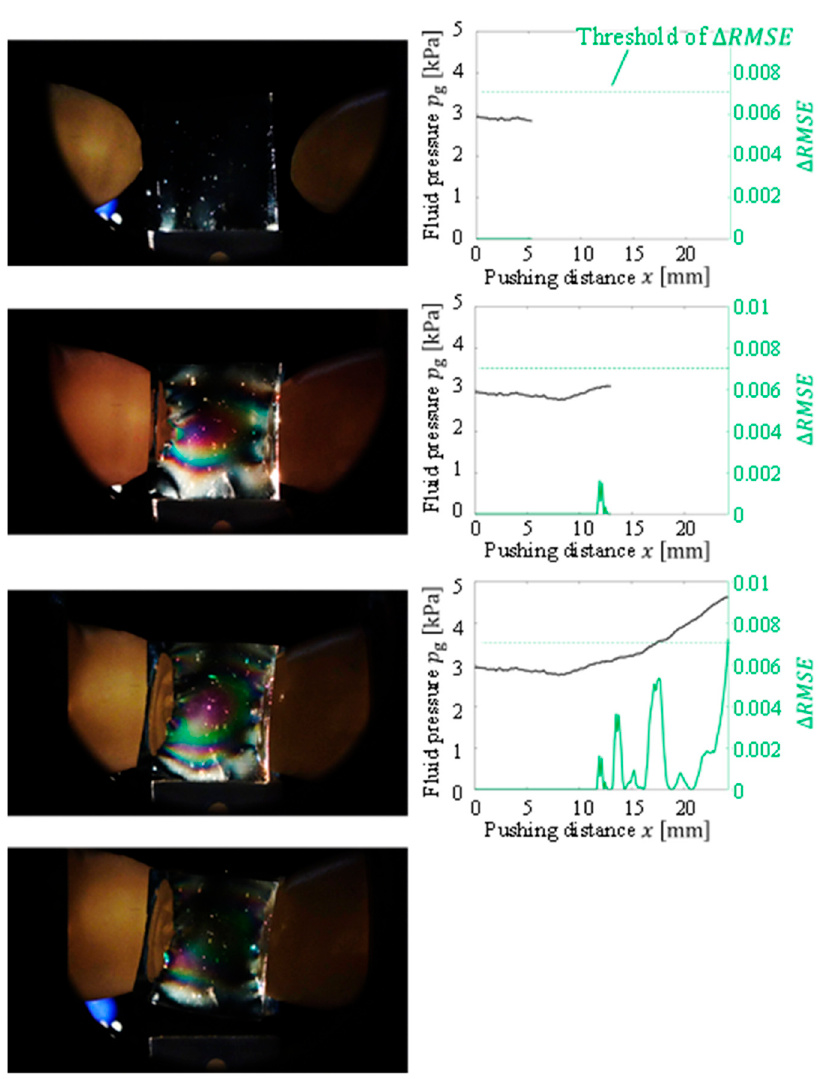
Figure 9. Overview of the grasping test (gelatin target)